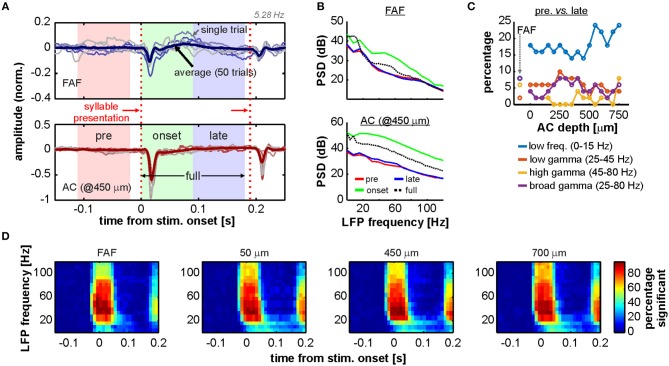
Onset related power increase in AC and FAF. (A) Representative LFP recordings of one penetration pair (FAF, top; AC at 450 μm, bottom), depicting six single trials for illustrative purposes (thin lines) and the average across all 50 trials. The time segments of pre, onset, late, and full, used for analyses (see main text), are indicated in the graphs. First and second syllable presentations of the 5.28 Hz train are indicated with vertical, red dashed lines. (B) Power spectral density (PSD) of the pre (red), onset (green), late (blue), and full (black, dashed) periods from the data depicted in (A) (average over the 50 trials), in the FAF (top) and AC (bottom). (C) Percentage of penetrations (after a total of 50) for which the power (at several frequency bands, indicated in the figure) was significantly different during the late period than during the pre period. (D) Time-frequency analysis illustrating the percentage of penetrations in FAF and AC (at three representative depths: 50, 450, and 700 μm) in which the power at a given time window was significantly higher than the power at a window preceding the stimulus onset.